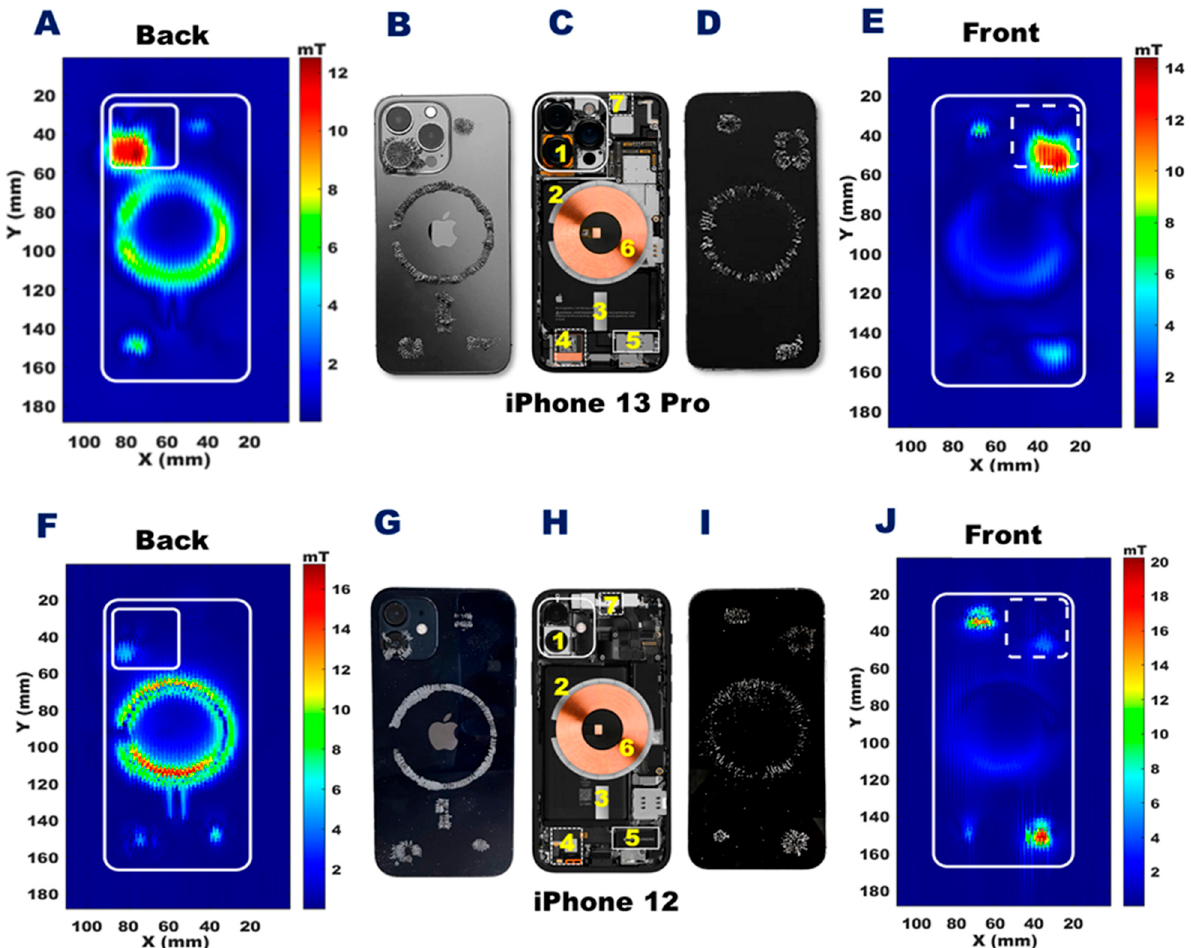
Figure 3. Spatial distribution of stray magnetic fields of the iPhone 13 Pro and the iPhone 12 across an FoV of 100 × 180 mm. The color scales represent the strength of the static stray magnetic fields and are scaled to the maximum B-field of each dataset. A , E : The 2D distribution of the stray magnetic field induced by an iPhone 13 Pro for a transversal plane placed at a z-distance of 4.4 mm from the back ( A ) and 1 mm from the front ( E ) plane of the device. F , J : The 2D distribution of the stray magnetic field induced by an iPhone 12 for a transversal plane placed at a z-distance of 2.5 mm from the back ( F ) and 1 mm from the front ( J ) plane of the device. C , H : Interior view of the iPhone 13 Pro ( C ) and the iPhone 12 ( H ) [33–35]. B , D , G , and I : The distribution of magnetic sand placed on the iPhone 13 Pro ( B : back, D : front) and on the iPhone 12 ( G : back, I : front) to illustrate regions with a strong stray magnetic field. 1 = wide-angle camera; 2 = annular array of magnets; 3 = magnetic strip; 4 = bottom speaker; 5 = Taptic Engine; 6 = charging coil, 7 = top speaker.